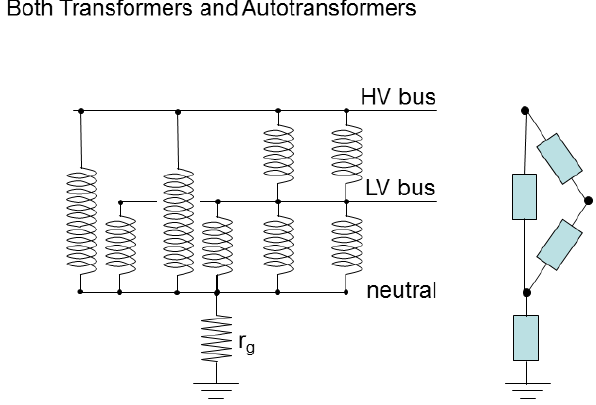
Figure 6. Scenario 3. Substation with both transformers and auto- transformers and equivalent admittances for the network